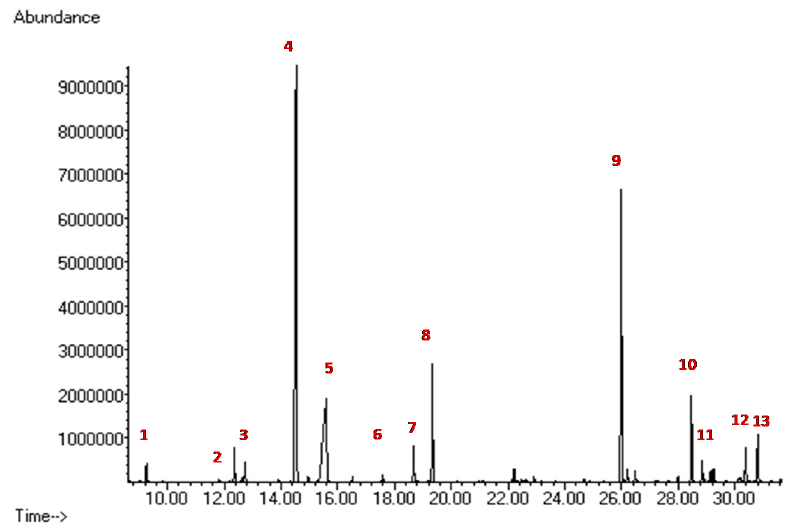
Figure3. GC-MSUrinaryorganicacidprofile. ( 1 )Lacticacid; ( 2 )3-hydroxypropionicacid; ( 3 )3-Hydroxy Figure 3. GC-MS Urinary organic acid profile. (1) Lactic acid; (2) 3-hydroxypropionic acid; (3) 3- butyric; ( 4 ) mma; ( 5 ) urea; ( 6 ) succinic acid; ( 7 ) fumaric acid; ( 8 ) 2-phenylbutiric acid (internal standard1); Hydroxy butyric; (4) mma; (5) urea; (6) succinic acid; (7) fumaric acid; (8) 2-phenylbutiric acid ( 9 ) 2-ketogluraric acid, ( 10 ) tricarballylic acid (internal standard 2); ( 11 ) cis-aconitic acid; ( 12 ) citric acid; (internal standard1); (9) 2-ketogluraric acid, (10) tricarballylic acid (internal standard 2); (11) cis- ( 13 ) hippuric aconitic acid; (12) citric acid; (13) hippuric acid.